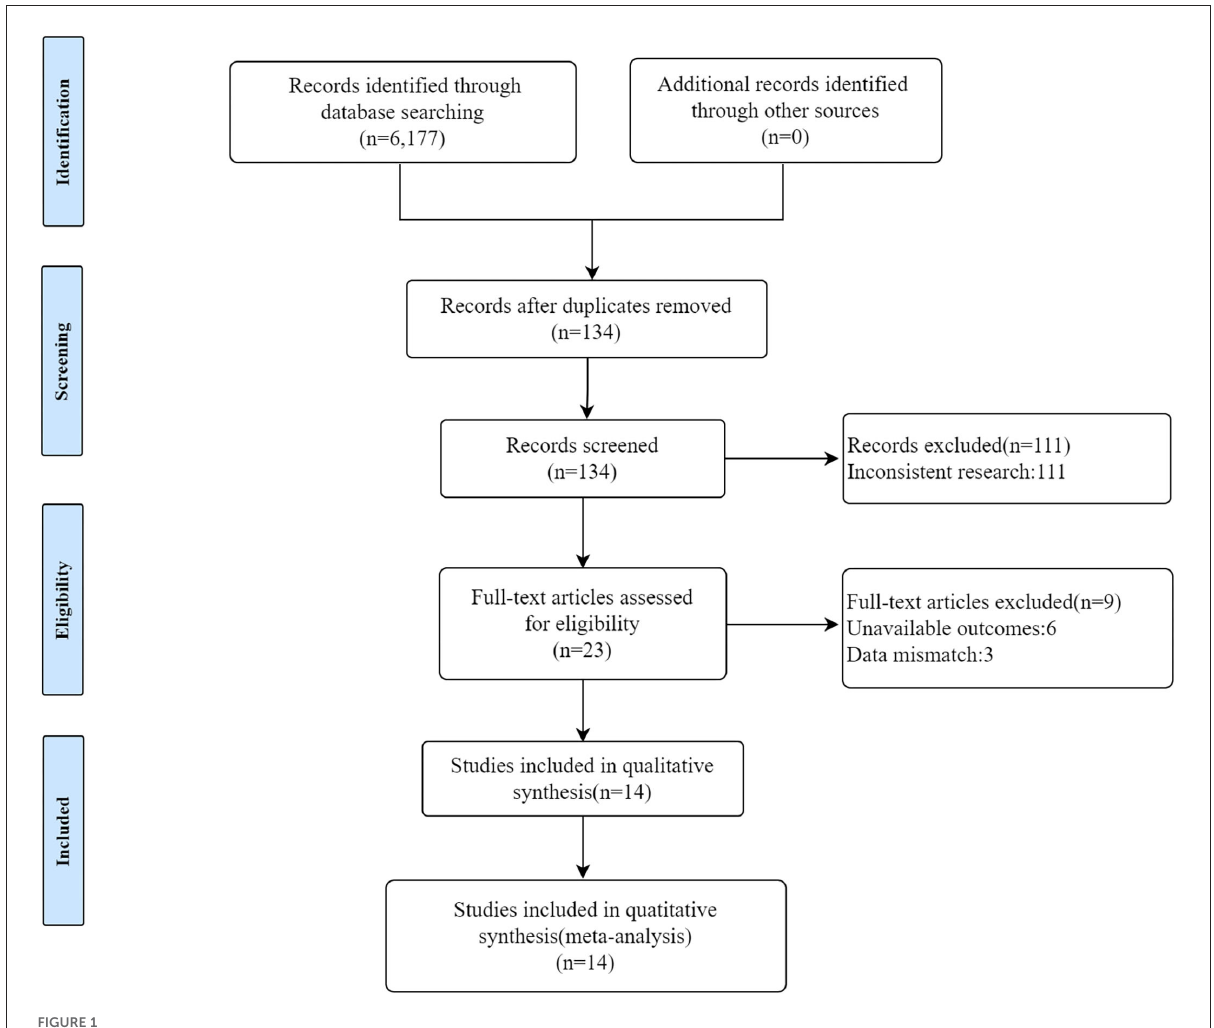
FIGURE1 Study flow